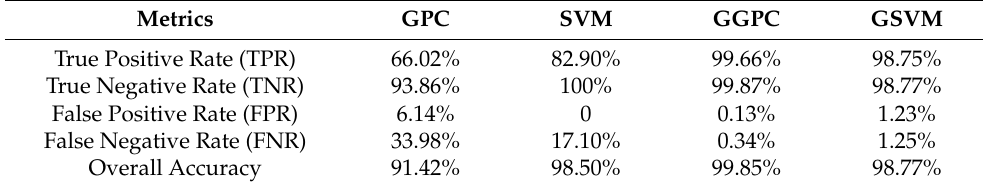
Table 6. Performance of the classifiers on the car-following scenario.